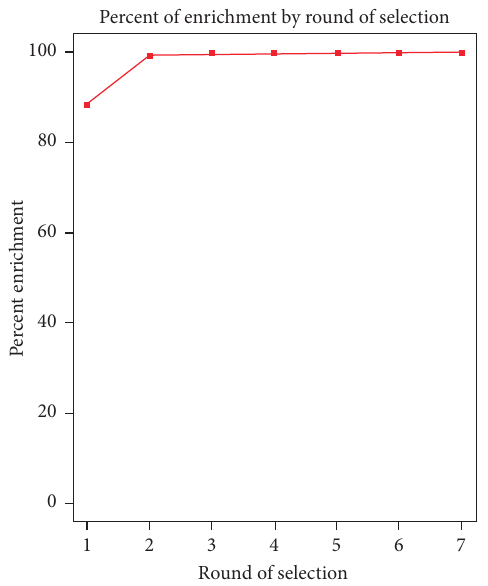
Figure 2: Percentage of enrichment of rounds (round 1 through 7) of the sequences obtained from MiaPaCa-2 HTS analysis; % Enrichment = 1 − (Unique sequence in individual round/Total seq- uence in individual round) × 100